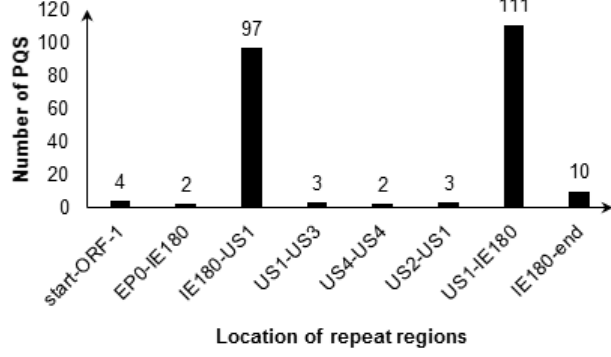
Figure 4. Distribution of G 2 -PQS in repeat regions in PRV genome.